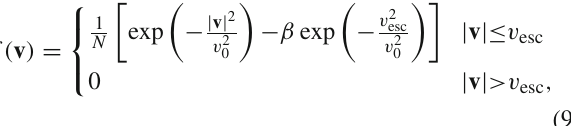
present the shift in the exclusion bounds as shown in Fig. 2 for F DM = 1. The light blue curves represent the exclu- sion bounds for the fiducial choice of v 0 and v esc . The other solid lines represent exclusion limits with the DMB sim- ulations. The dashed lines represent exclusion limits with DMO simulations. The orange and red lines corresponds to APOSTLE and ARTEMIS simulations respectively. For the APOSTLE DMB simulation, we observe a maximum change (cid:3) ∼ O ( 30% ) in the cross section relative to the fiducial